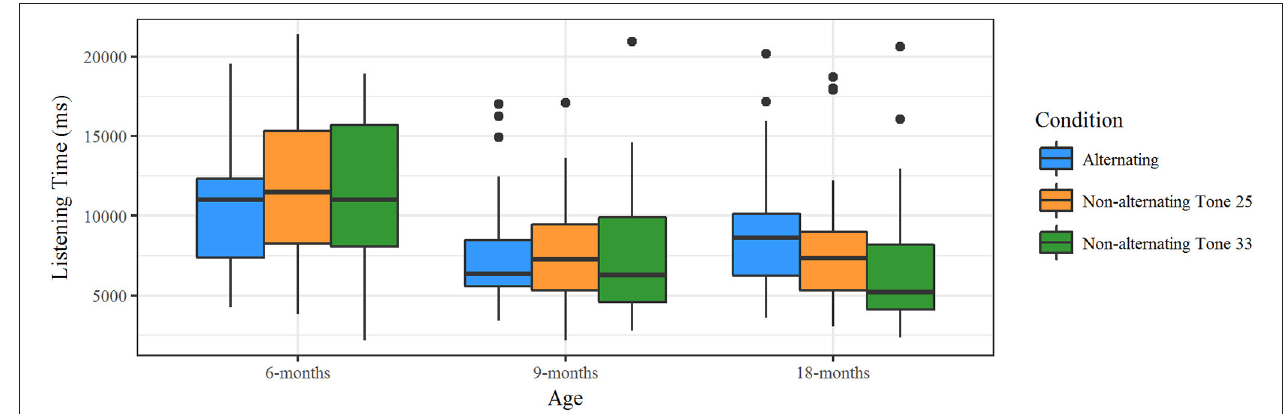
FIGURE 3 | Results from the familiarization experiment divided by age group. Mean listening times for the alternating trials were only significantly longer at 18 months, indicating that only the 18-month-olds discriminated the lexical tones.